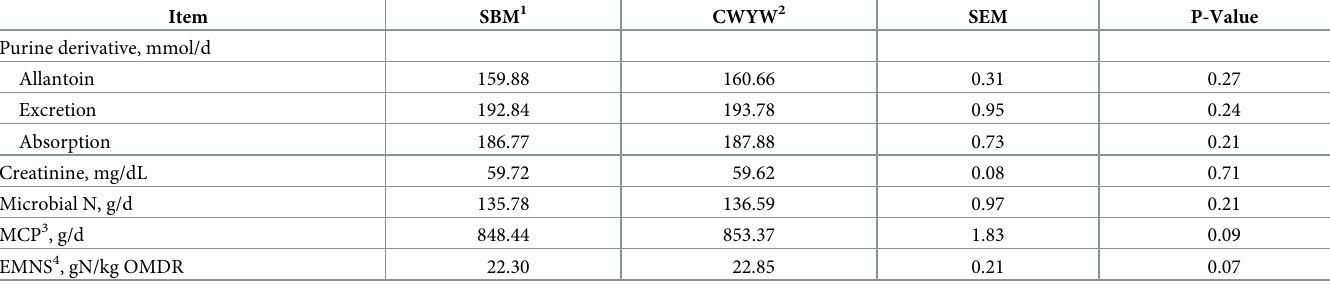
Table 5. Effect of replacing soybean meal with citric waste fermented yeast waste on urinary purine derivative and microbial protein synthesis. Item